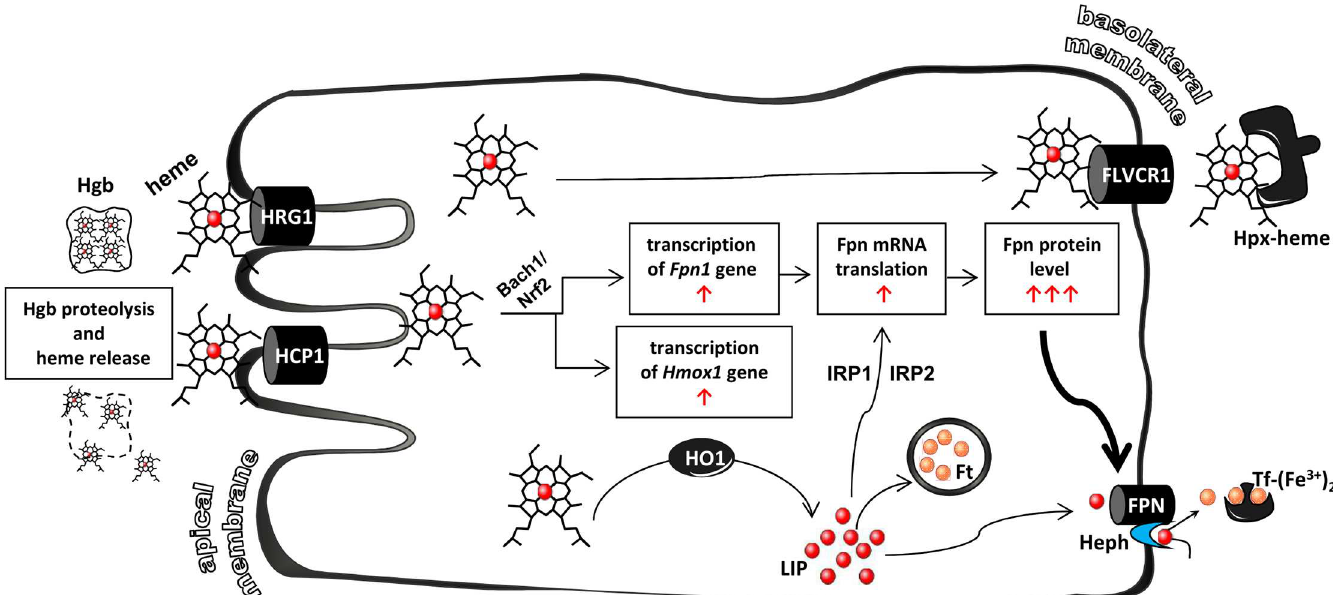
Fig 7. Proposed pathways and regulatory mechanisms of heme iron absorption in piglets supplemented with dietary hemoglobin. Before heme iron can be utilized,heme must be extracted from hemoglobin by proteolyticactivity in the stomach and duodenum. Intestinal heme uptake occurs in the proximalpart of the duodenum. The first step in heme iron absorption involvesintact heme transport across the apical membraneto the enterocyte interior via the HCP1 and HRG1 importers. The passageof heme iron through the enterocyte then dividesinto two separate pathways. First, intracytoplasmic heme can be catabolized by heme oxygenase 1 (HO1), a process leadingto the releaseof ferrous iron. Freed heme iron is then neutralizedby ferritin, a cytosolic multimeric iron-storageprotein, or recycled to the circulation via ferroportin (Fpn), where it is bound by transferrin (Tf). Free heme, apart from being a substrate of the enzymatic reactioncatalyzed by HO1, may induce the expressionof both Hmox1 and Fpn genes at the transcriptional level via the MARE/ ARE sequencemotif, a regulatorymechanismthat involvesinactivationof the transcriptional repressor Bach1 and the recruitment of the transcriptional activator Nrf2. In addition,iron extracted from the protoporphyrin ring of heme can promote the translation of the Fpn transcript containing the Iron Responsive Element (IRE) in its 5’ UTR via the Iron Regulatory Proteins. Finally, up-regulation of Fpn on the enterocyte basolateralsurface of hemoglobin- fed pigletsmay be due to the reducedbindingof hepcidin(showinga residualconcentration in the blood plasma)to cell surface Fpn and thus to its limited internalization and degradation. Orchestrated up-regulation of Fpn expressionin duodenalenterocytesat different regulatorysteps may be a key event in understanding high heme bioavailability. The second, minor, pathway of heme iron movement involvesthe transport of intact heme, not catabolized by HO1, across the basolateralmembraneby FLVCR1 to the plasma, where it is capturedby hemopexin(Hpx) and deliveredin the form of heme-hemopexin via receptorCD91 to varioussites in the